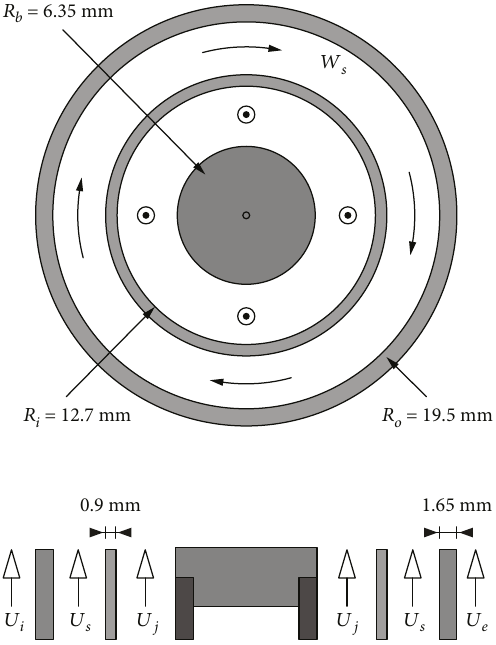
Figure 1: Schematic of the Cambridge swirl burner